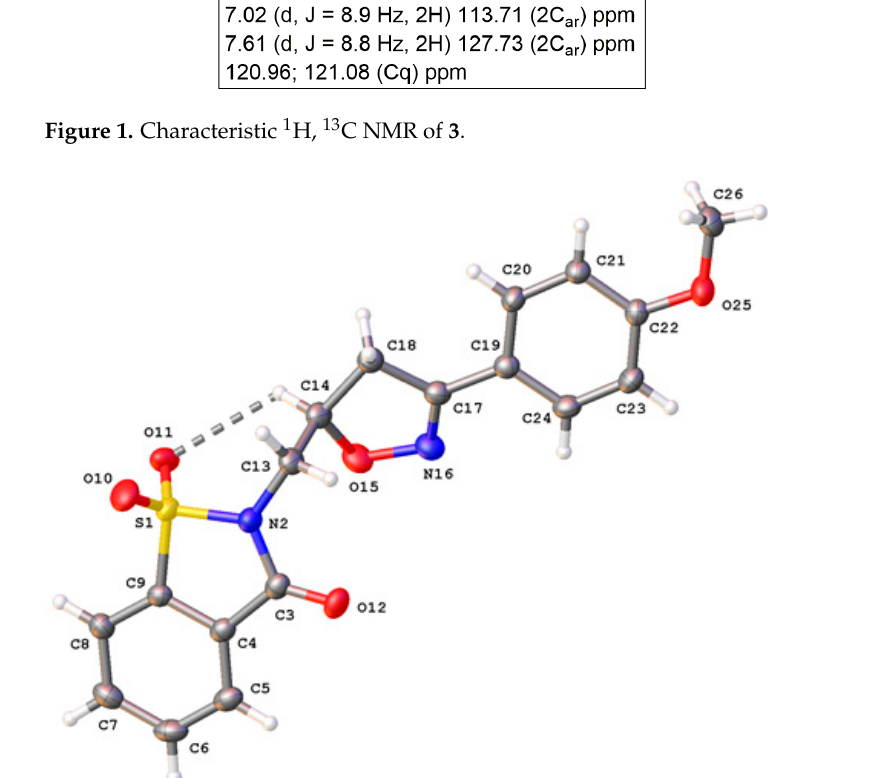
Figure 2. The ORTEP diagram of compound 3 with the atom labeling scheme and 30% probability ellipsoids. The intramolecular hydrogen bond C14–H14 . . . O11 is shown as a red dashed line. The isoxazoline ring is slightly puckered (envelope conformation with C14 as flap, puck- ering parameters Q(2) = 0.171(2) Å, ϕ (2) = 325.2(7) ◦ ). Furthermore, an